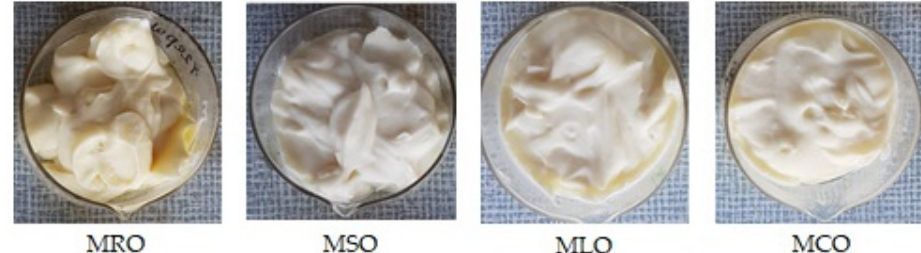
Table 1. Ingredients of different formulations of vegan mayonnaise samples.